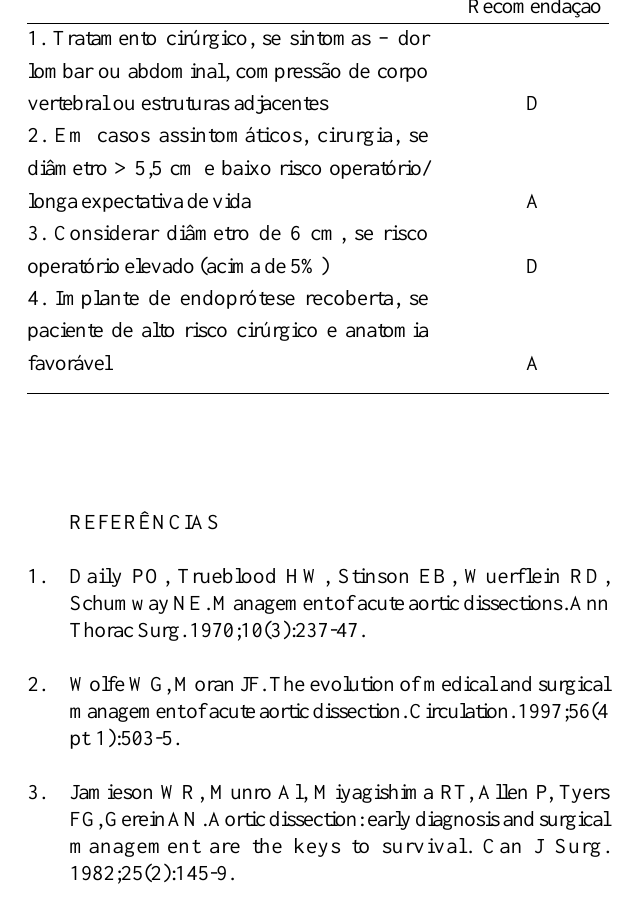
Tabela 5. Critérios de intervenção nos Aneurismas Aórticos Infra-